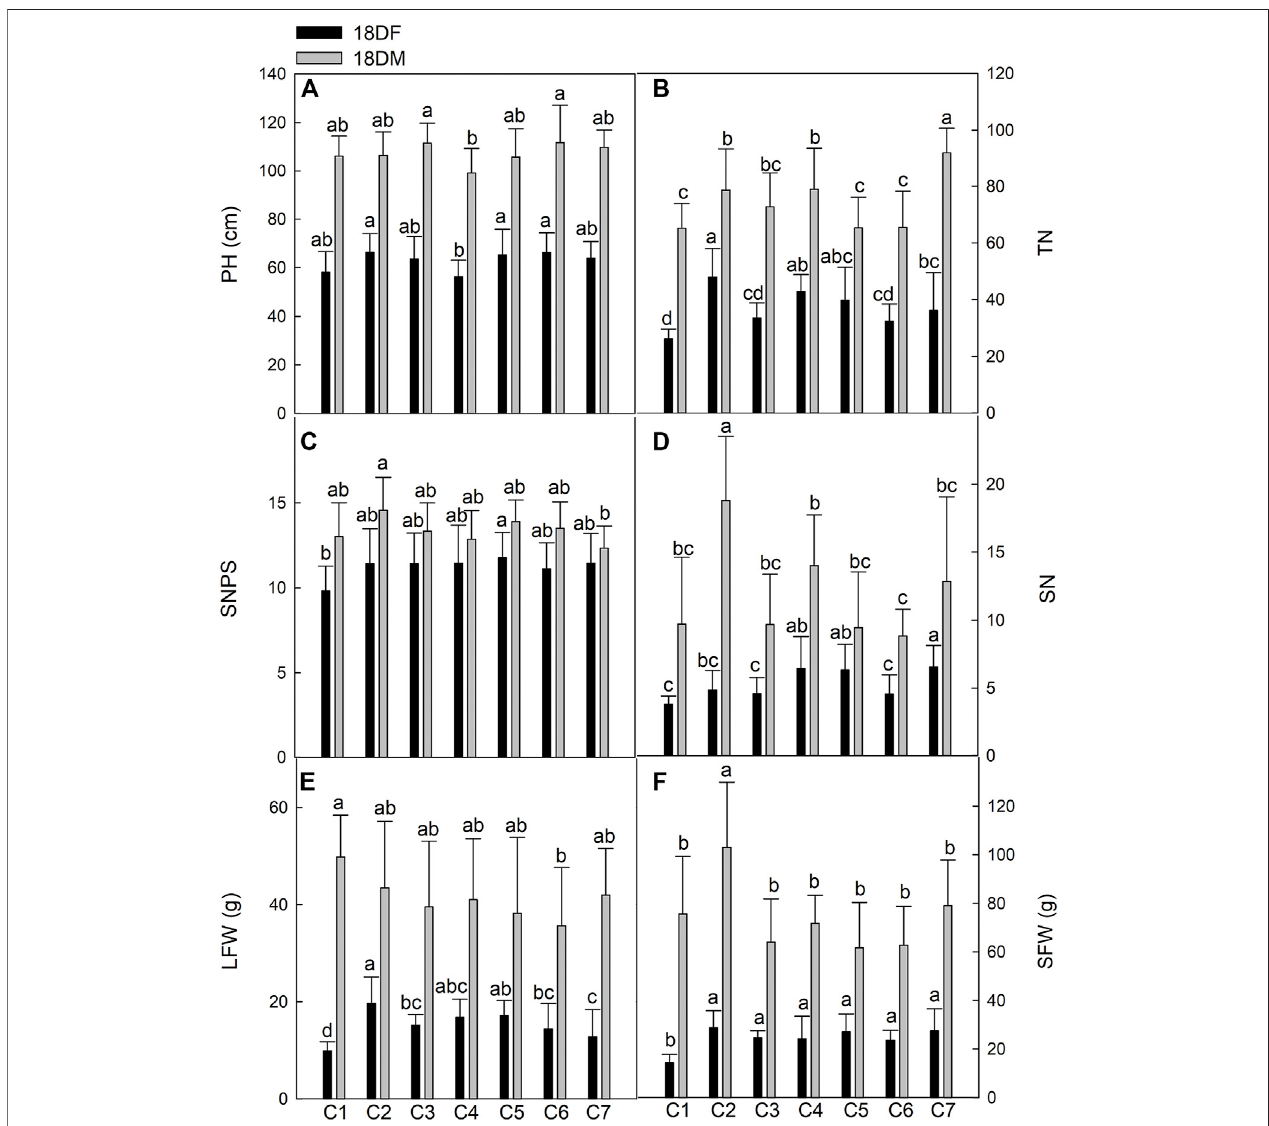
FIGURE 3 | Comparison of main agricultural traits of seven Th. ponticum lines at Dongying station during different growth periods. (A) Plant height (PH). (B) Tiller number (TN). (C) Spikelet number per spike (SNPS). (D) Spike number (SN). (E) Leaf fresh weight (LFW). (F) Stem fresh weight (SFW). Different letters indicate a signi fi cant difference between seven Th. ponticum lines at p < .05